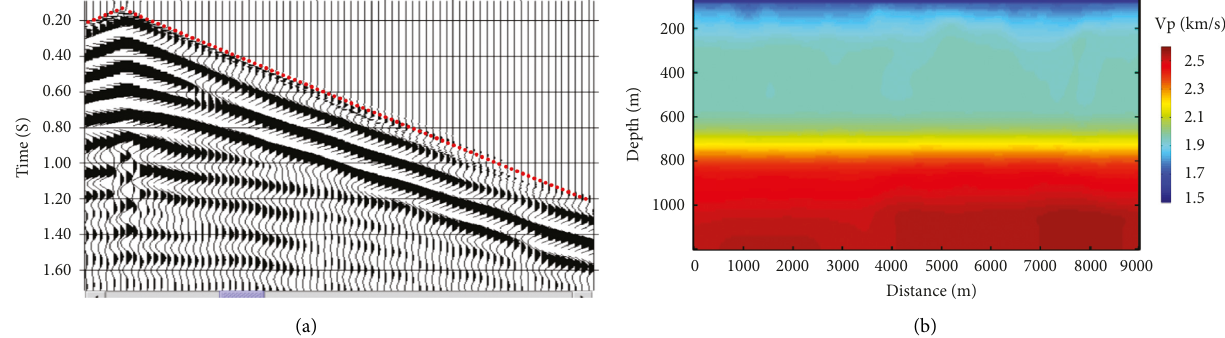
Figure 7: (a) CSG 50 from the marine seismic data: red dots denote the picked first-arrival travel times. (b) The inverted model of first- arrival travel time tomography.